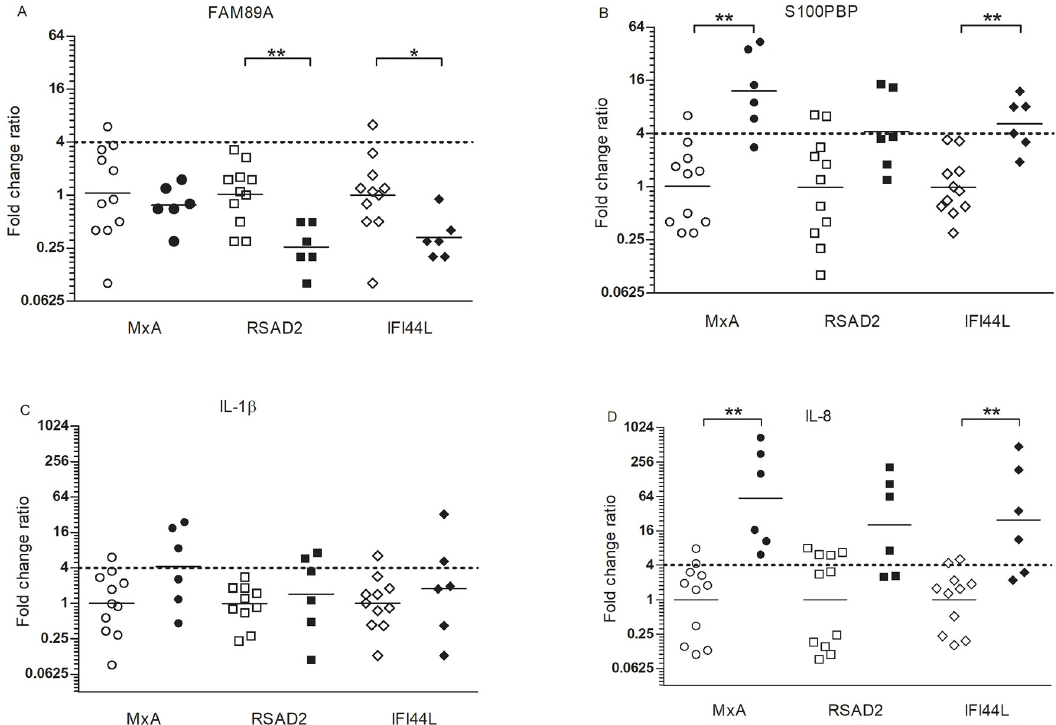
Fig 3. Fold change ratios in A . pleuropneumoniae infected pigs. Fold change ratios were calculated as fold change of bacterial markers FAM89A (A), S100PBP (B), IL-1 β (C) or IL-8 (D) divided by fold change of the viral markers MxA , RSAD2 and IFI44L in eleven SPF pigs (open symbols) and six pigs with an A . pleuropneumoniae infection (filled symbols). Fold change ratio = 4 is depicted by the dotted line. � p < 0.05, �� p < 0.01.